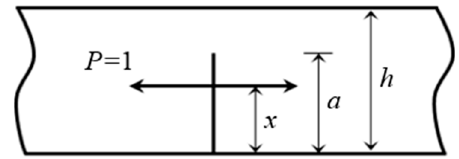
Figure 19. Beam applied a pair of tensile unit point forces.